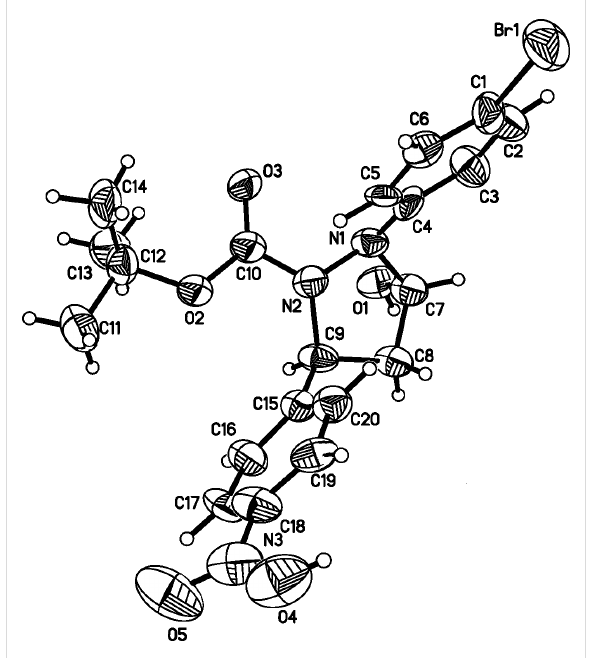
Figure 4: The X-ray crystal structure of chiral compound 4s (40% thermal